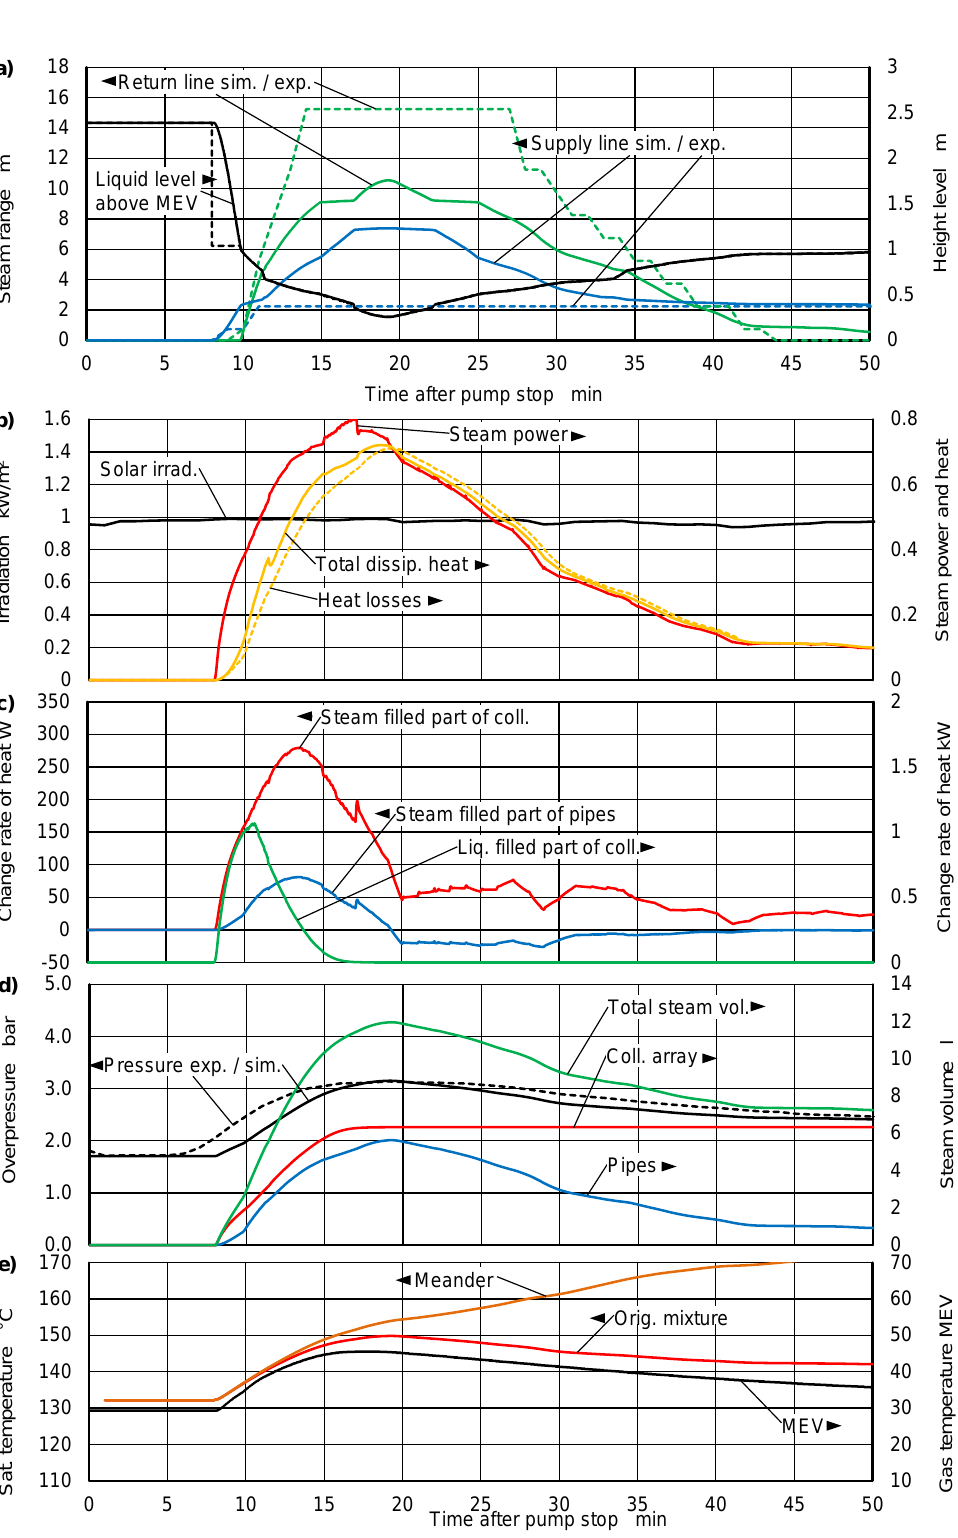
Figure 13. Experimental and simulation results for the system with standard selective absorbers. Active check valves. Dataset 07−26. ( a ) Steam range and level height, ( b ) Steam power, heat losses and irradiation, ( c ) Change rates of heat, ( d ) Overpressure and steam volume, ( e ) Saturation temperature and gas temperature inside MEV.